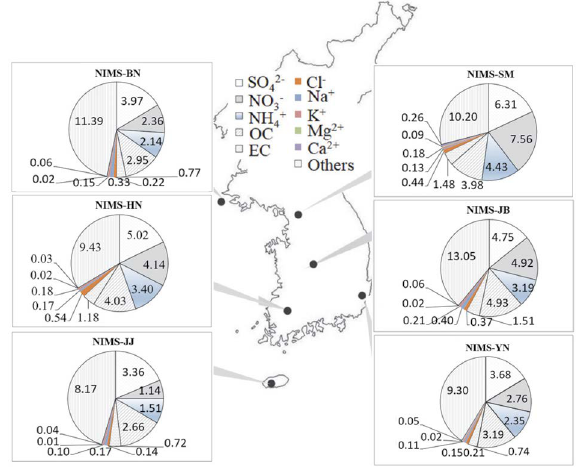
Fig. 6. A site map with pie charts showing 6-yr average composi- tions for 10 chemical species in PM 2.5